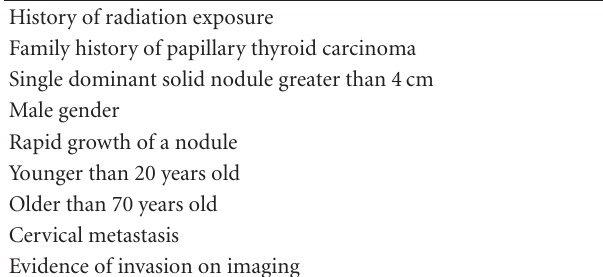
Table 1: Risk factors for thyroid carcinoma. Table 2: AGES classification system.